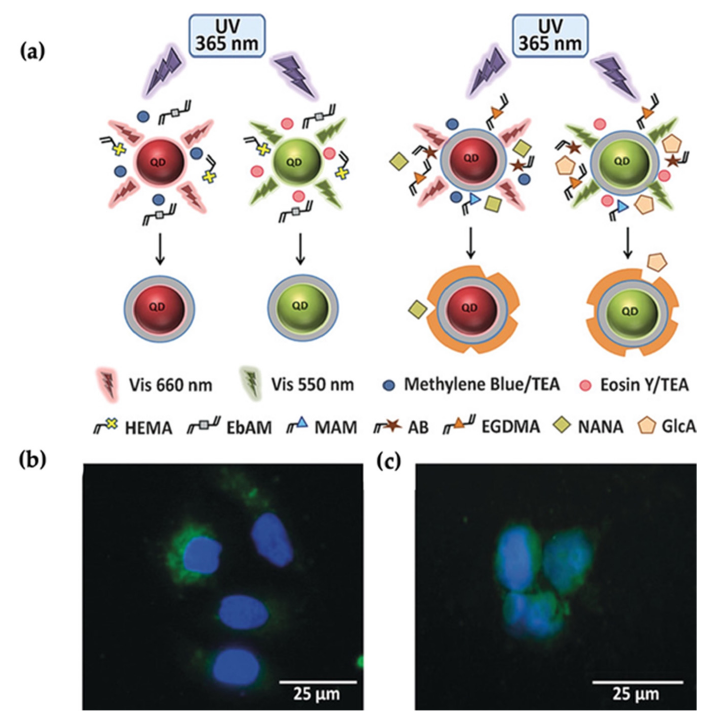
Figure 14. ( a ) Demonstration of red and green light emitting QDs excited by UV and MIP shell around the particles. ( b , c ) Staining of keratinocytes, ( b ) KU812 cells, ( c ) with MIP@QDs Reproduce with permission from [98].